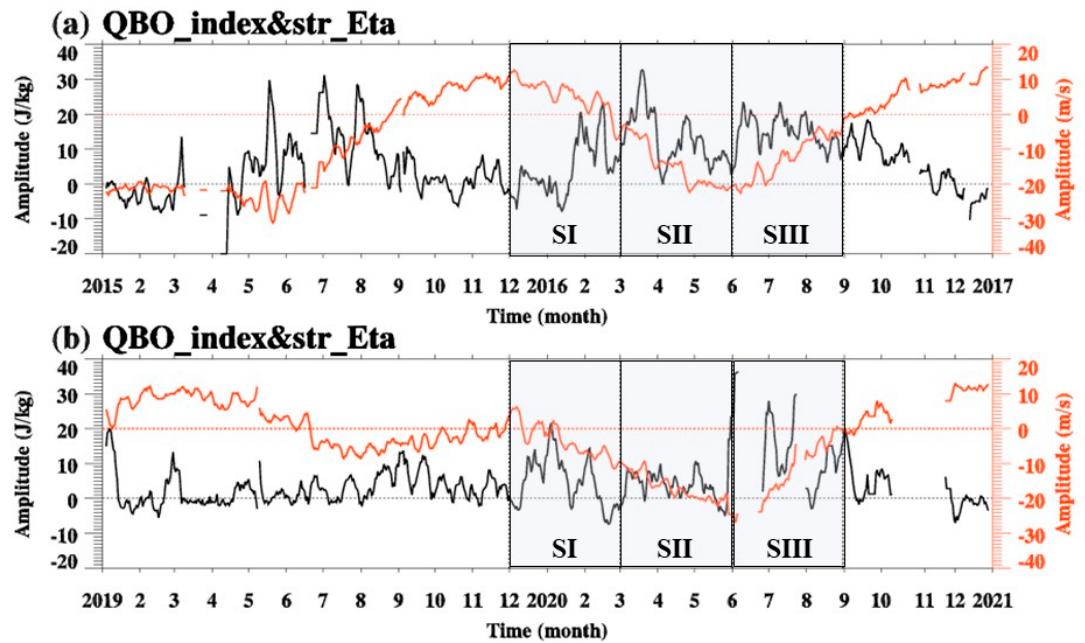
Figure 4. The time series of the QBO index and stratospheric E t anomaly over Ponape Island station (6.97 ◦ N, 158.22 ◦ E) in ( a ) 2015/2016 and ( b ) 2019/2020. The red lines denote the QBO index. The black lines indicate the stratospheric E t anomaly. The horizontal lines represent wind speed, which is 0 m/s (red line), and energy density anomaly, which is 0 J/kg (black lines). Boxes indicate SI, SII, and SIII stages.